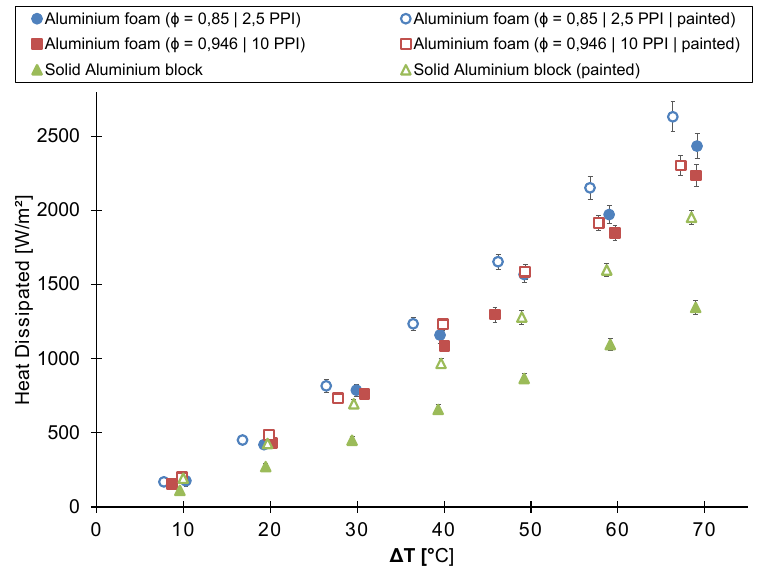
Figure 10. The heat dissipated by the unpainted and painted heat sink as a function of the temperature difference between the ambient air and the heat sink’s base plate (heat sink’s height = 40